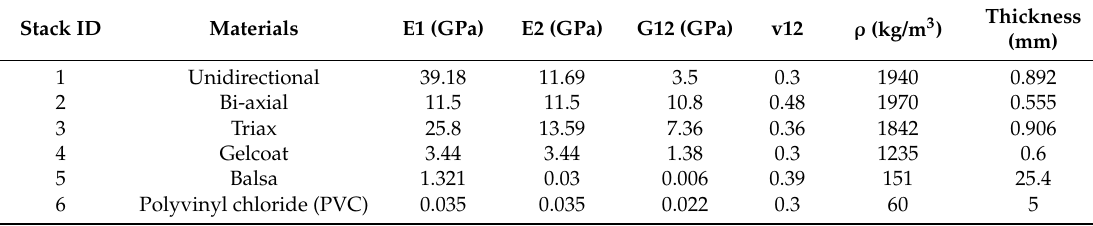
Table 4. The material properties.